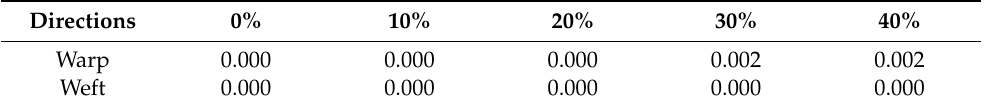
Table 2. The p values of significances among samples 2 × 2, 2 × 4, 2 × 6 and 2 × 8 under different water absorption ratio.